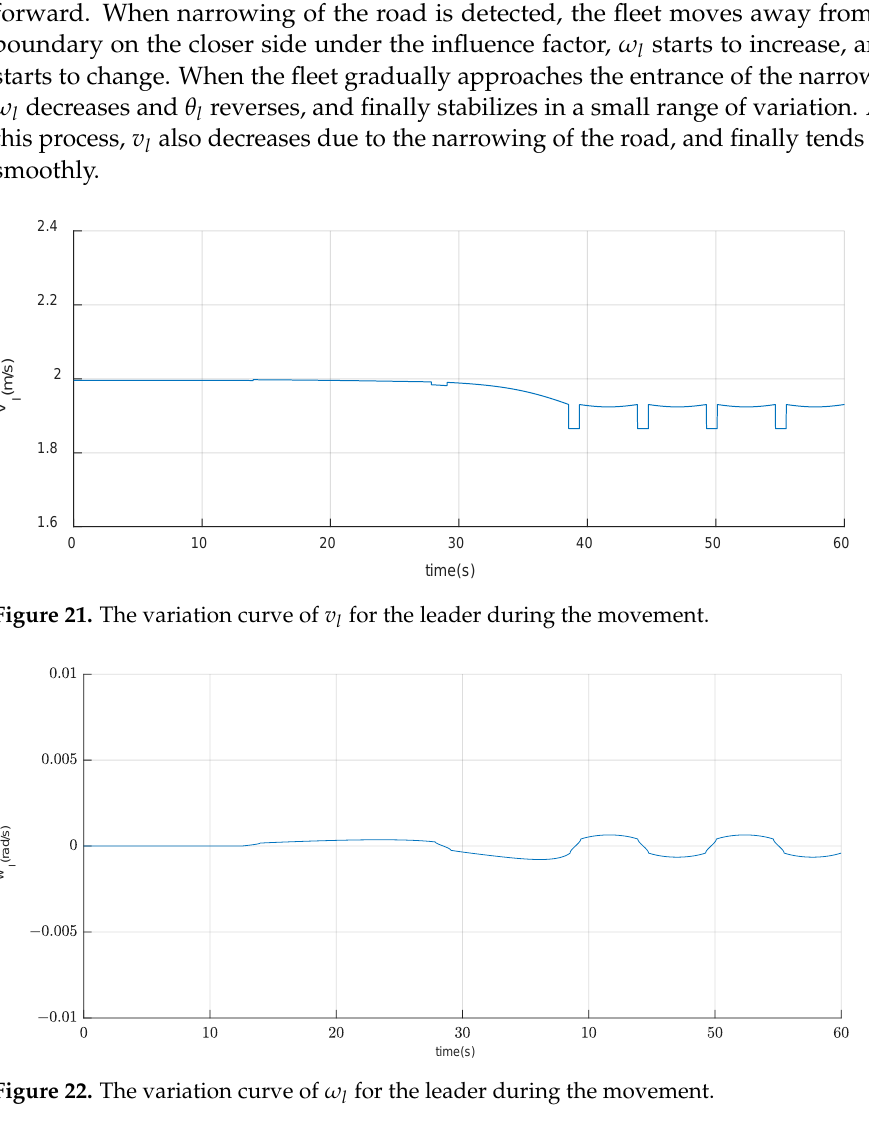
Figure 22. The variation curve of